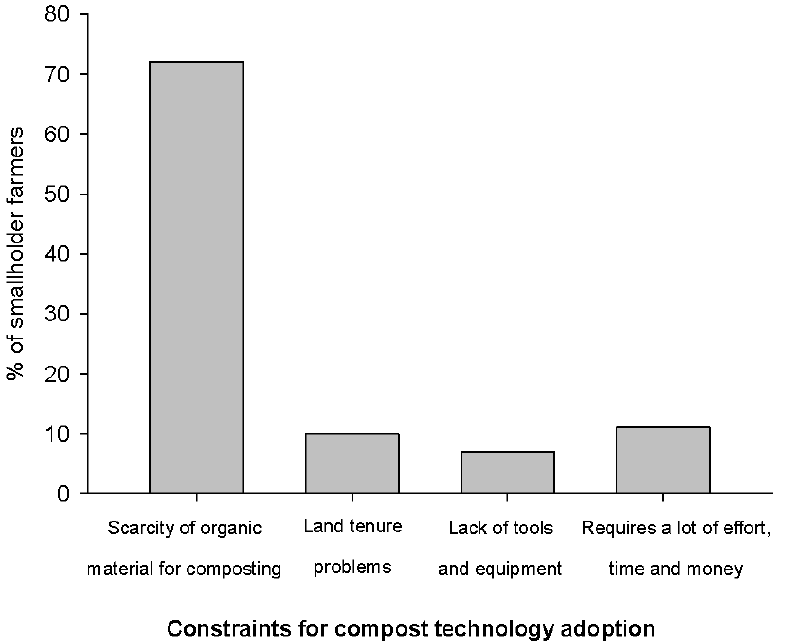
Figure 4. Constraints of smallholder farmers in Southern Ethiopia for producing and applying com- post.